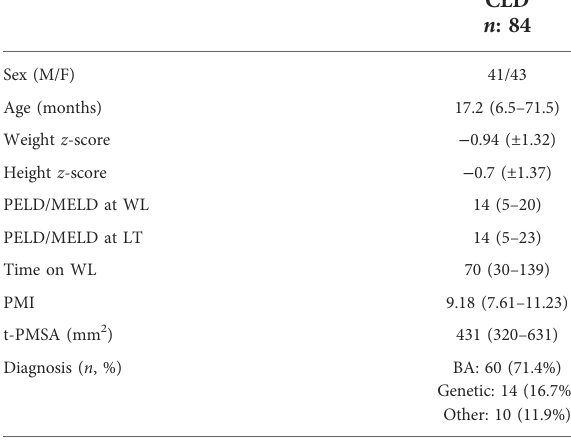
TABLE 1 Anthropometric characteristics of CLD population.